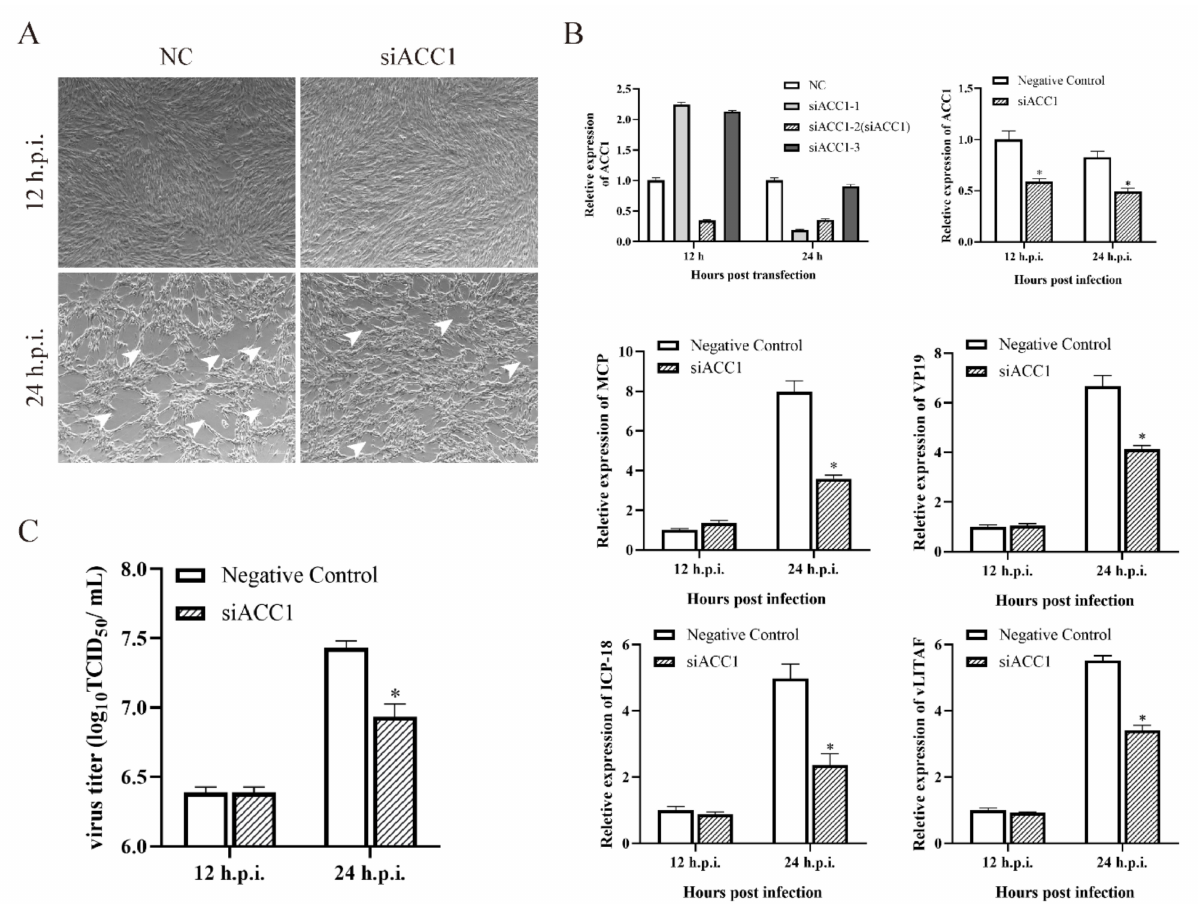
Figure 4. Roles of ACC1 during SGIV replication. CPE of siRNA on GS cells during SGIV infection ( A ). Selection of siRNA, and the most effective siRNA of ACC1 suppress SGIV genes transcription during SGIV infection ( B ). Effects of siRNA on SGIV TCID 50 during SGIV infection ( C ). n = 3, data are expressed as means ± SD, * indicates p <